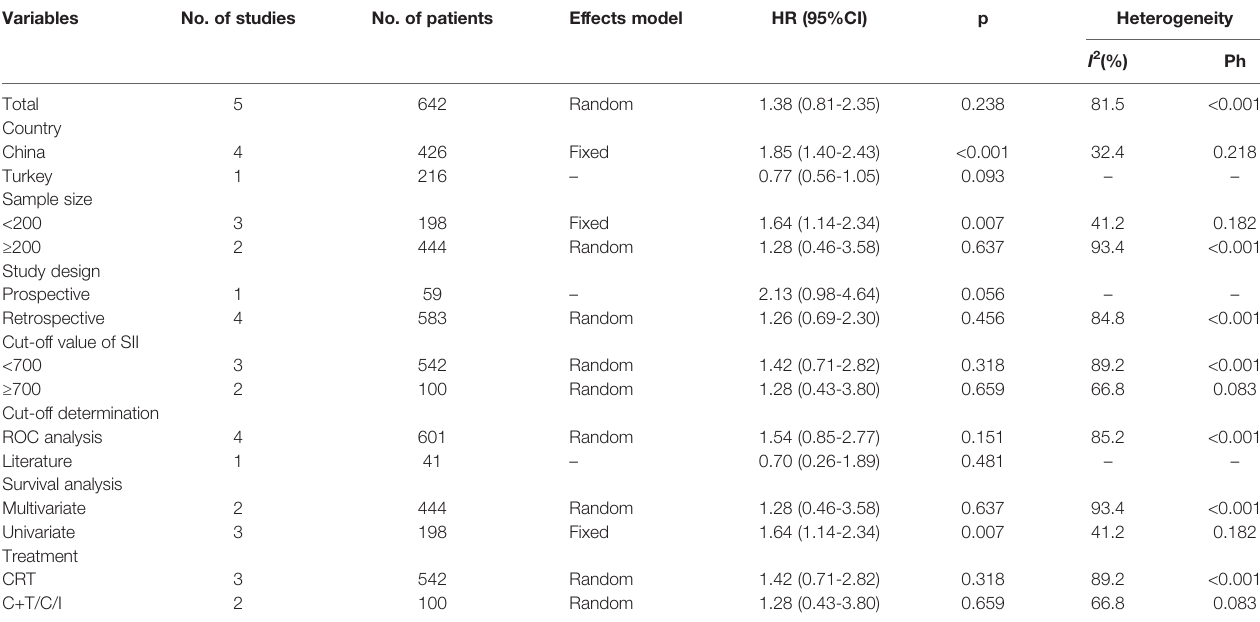
TABLE 3 | Subgroup analysis of the prognostic value of SII for progression-free survival in patients with SCLC. Variables No. of studies